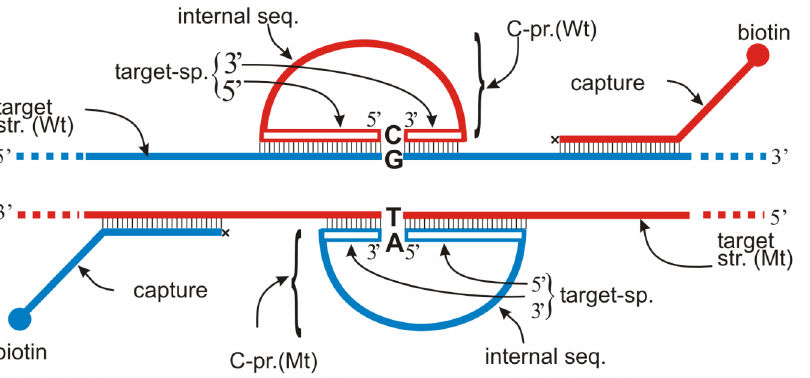
Figure 1. Nucleic acid species used for detection of alleles at a locus via the RAM reaction. The figure shows a wild type (Wt) target strand in blue (‘‘target str. (Wt)’’) and a mutant (Mt) target strand in red (‘‘target str. (Mt)’’). A C-probe (‘‘C-pr. (Mt)’’ and ‘‘C-Pr. (Wt)’’) is shown bound to each target strand via target-complementary 5 9 and 3 9 target-specific segments; the C-probe’s internal sequence (‘‘internal seq’’) is not complementary to the target sequence. The SNP base is shown in bold-face in the target strands and in the C-probes. A 3 9 blocked (x) capture-probe that terminates in a 5 9 covalently bound biotin molecule is drawn annealed to each DNA strand.